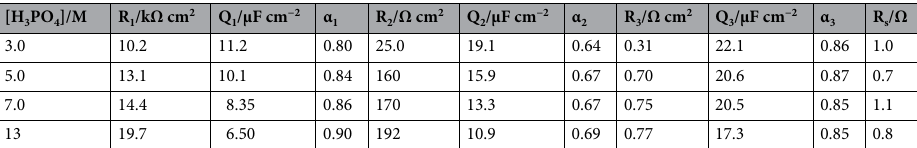
Table 4. Impedance parameters of Mo electrode as a function of phosphoric acid concentration at 298 K.